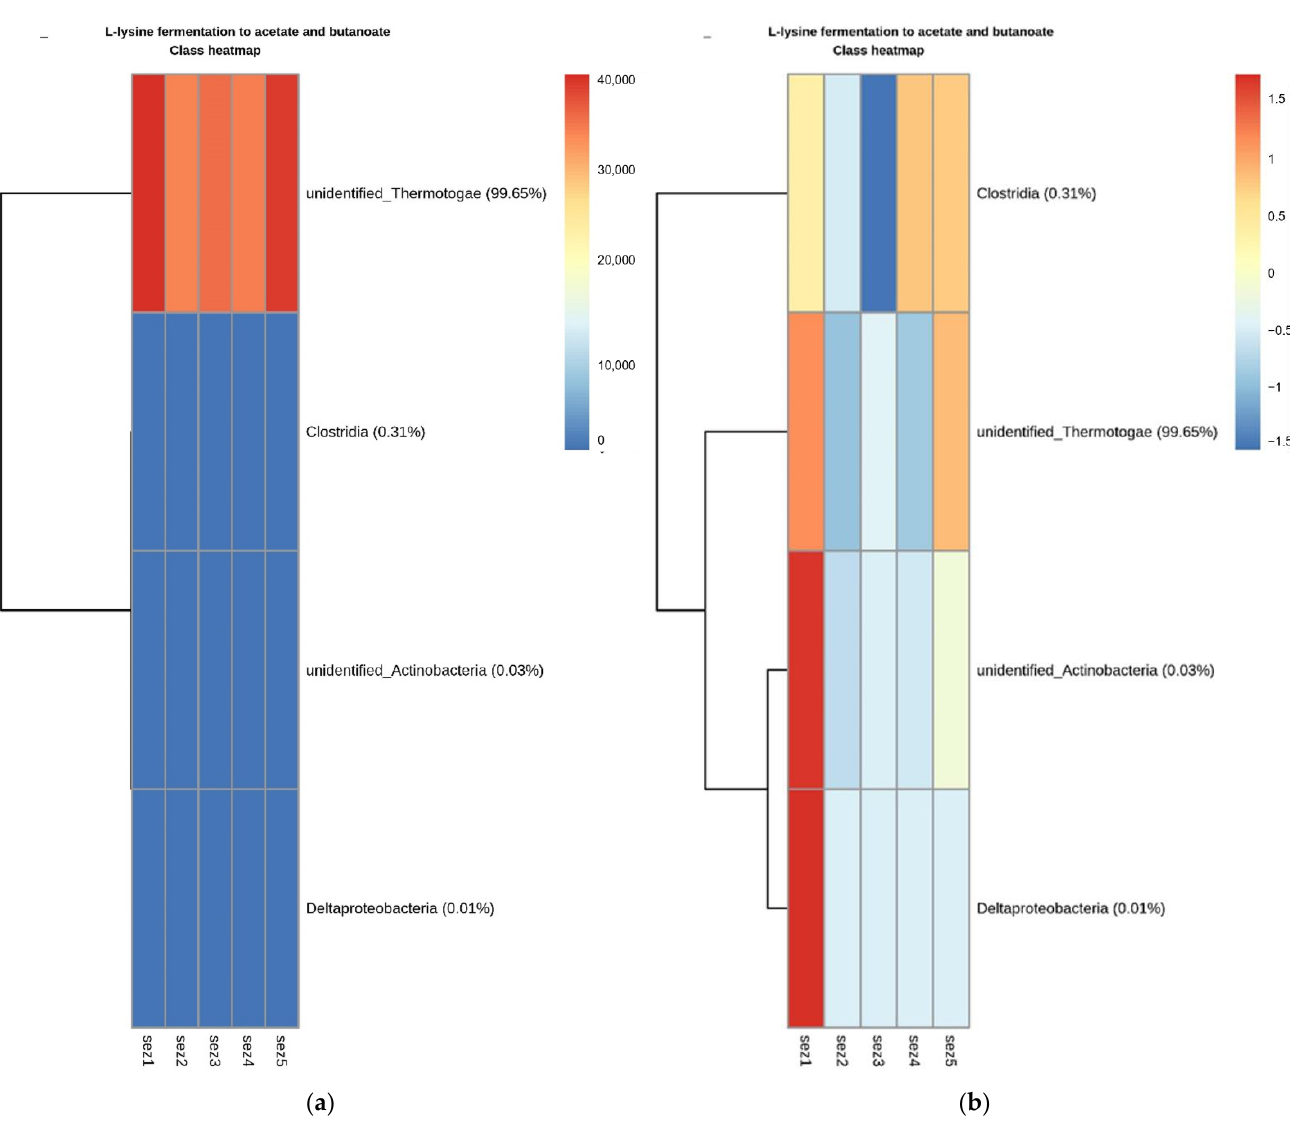
Figure A1. Functional heatmaps of L-lysine fermentation to acetate and butanoate: ( a ) absolute counts and ( b ) autoscaled counts, aggregated at the class level.